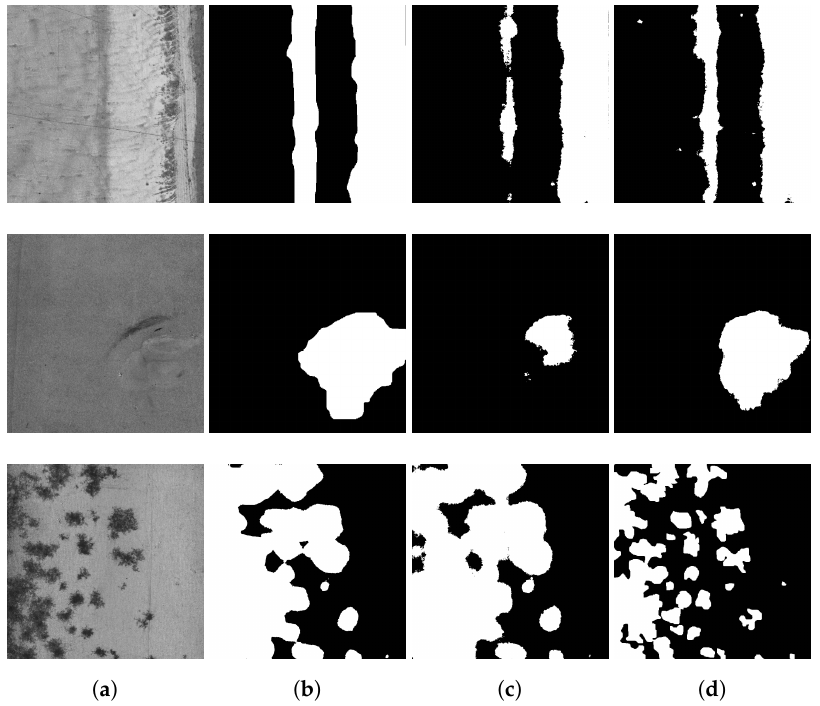
Figure 8. Detection of defects using two instances of the DeepLabv3+ semantic segmentation neural network. ( a ) photometric-stereo texture channel images; ( b ) ground truth masks; ( c ) predictions with the original RGB photometric-stereo database; and ( d ) predictions adding GAN-generated RGB photometric-stereo images. Table 1. Different variations of the GAN generated images ratio in the data augmentation of the original RGB training set and the respective mean IoU values (%) of the validation process for each